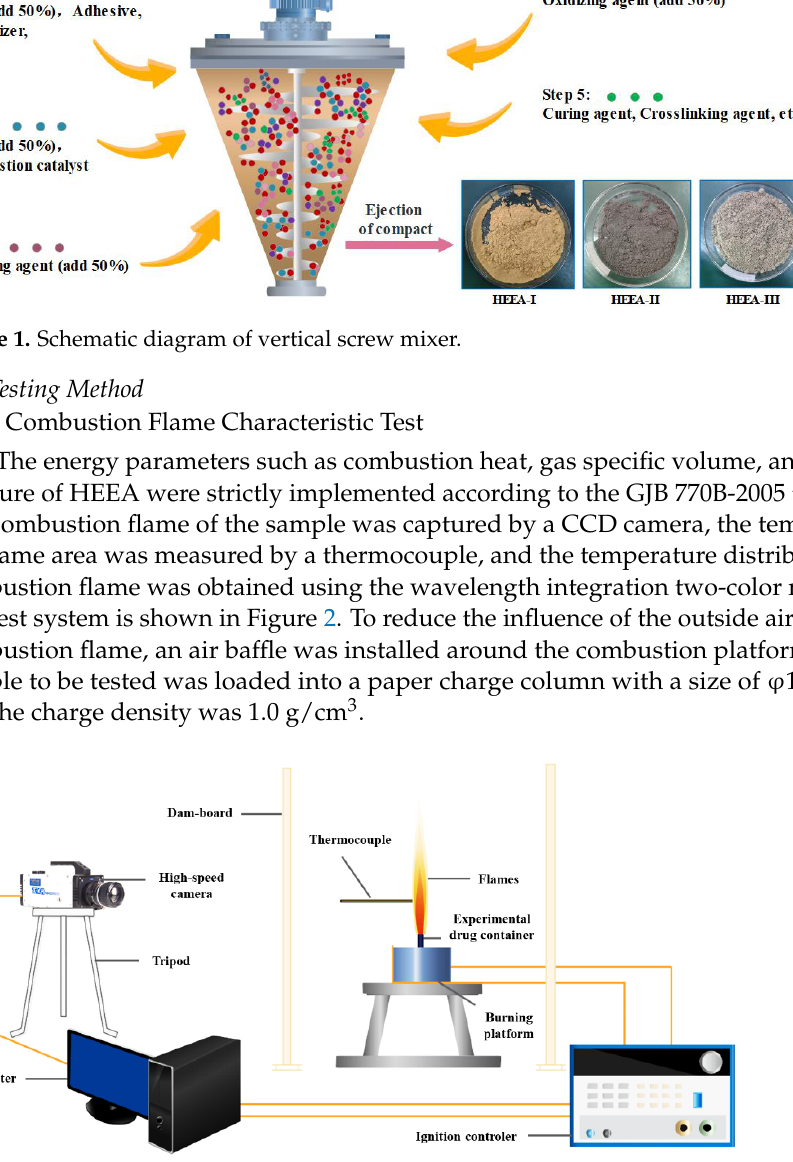
Figure 2. Hartmann flame propagation test device.